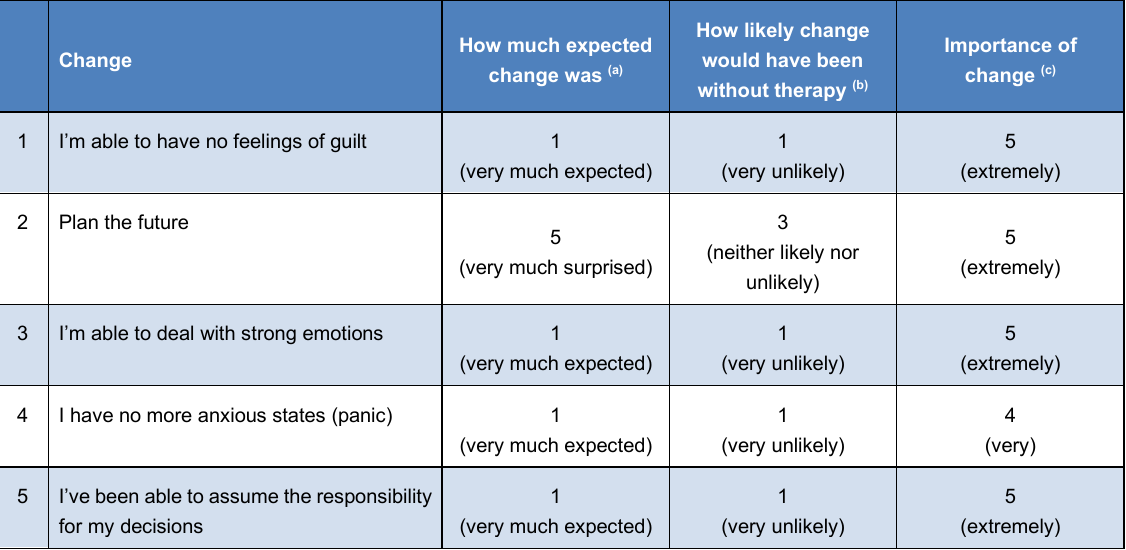
Table 4: Beatrice’s Changes identified in the Change Interview